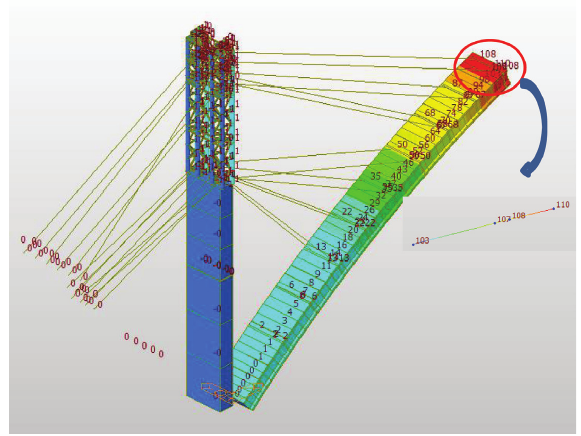
Figure 23: Vertical deformation after tensioning buckle cable and anchor